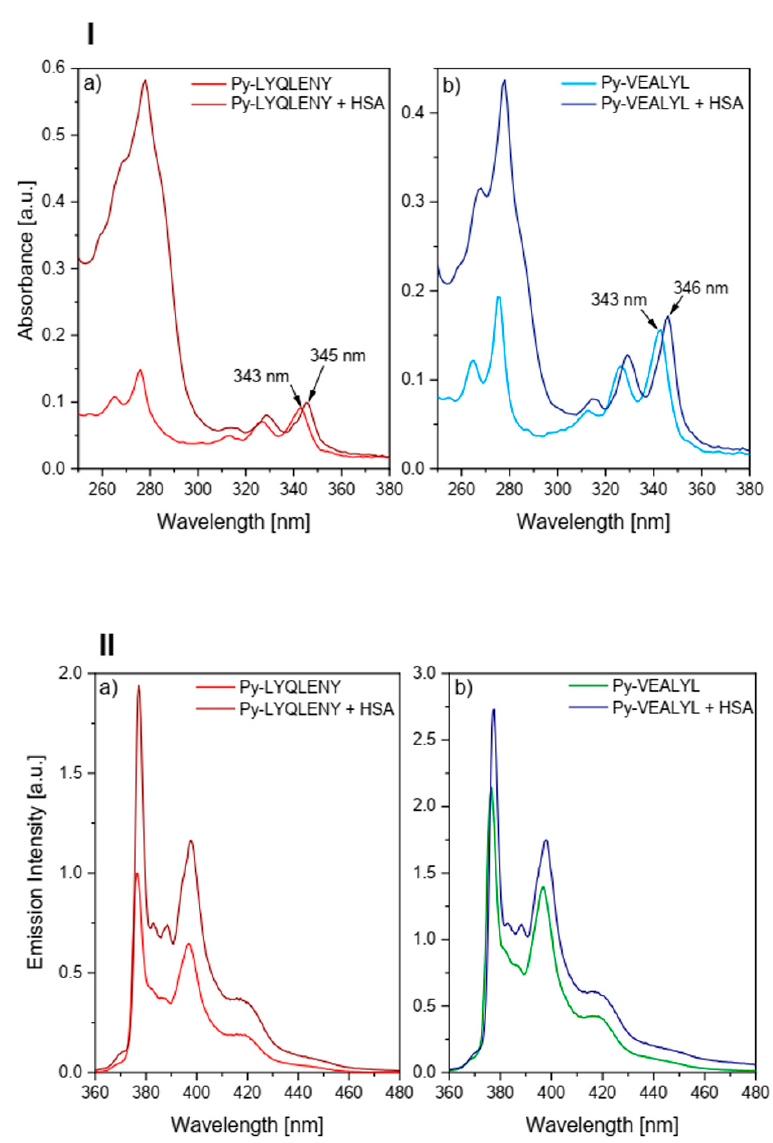
Figure 4. Panel I: absorbance spectra of ( a ) Py-LYQLENY ( 2 ) and ( b ) Py-VEALYL ( 3 ) in the presence and absence of HSA. [HSA] = 30 µ M. Panel II: fluorescence spectra of ( a ) Py-LYQLENY and ( b ) Py-VEALYL in the presence and absence of HSA. [HSA] = 30 µ M, λ exc = 337 nm.